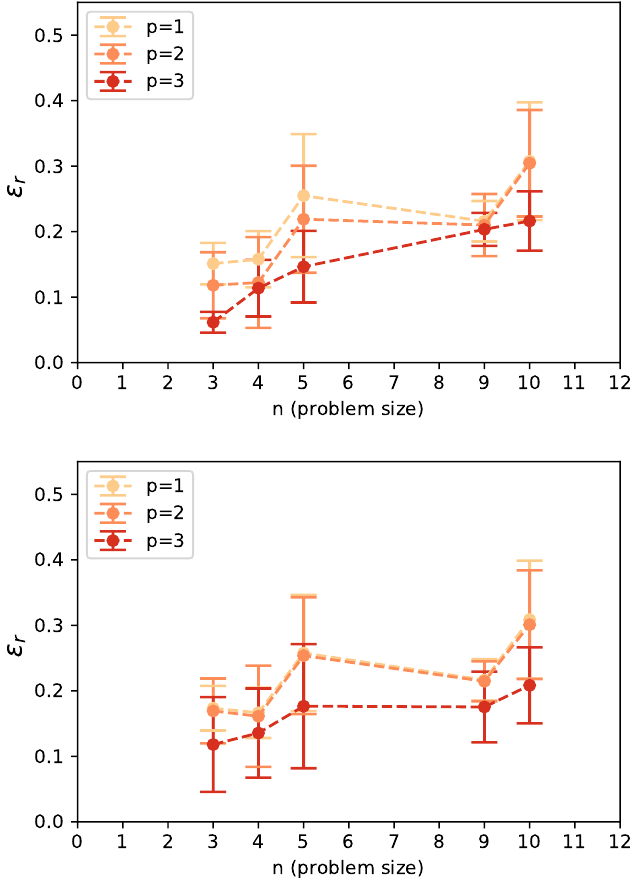
Figure 3: Comparison of converged final relative error (median), for p ∈ { 1,2,3 } , as a function of problem size n ∈ { 3,4,5,9,10 } , done on 5 problem instances per n with a budget of 200 iterations. (TOP) shows the results from the optimization having access to the exact waveform (statevector simulator), while (BOTTOM) shows the results using a shot-noise simulator with 2 n + 2 shots. For drawing the bottom plot, we use the best angles found using shot-based optimization and used the statevector QVM for one more run at those angles in order to compute the exact expectation value and corresponding relative error. These results are from the experiments described in Section